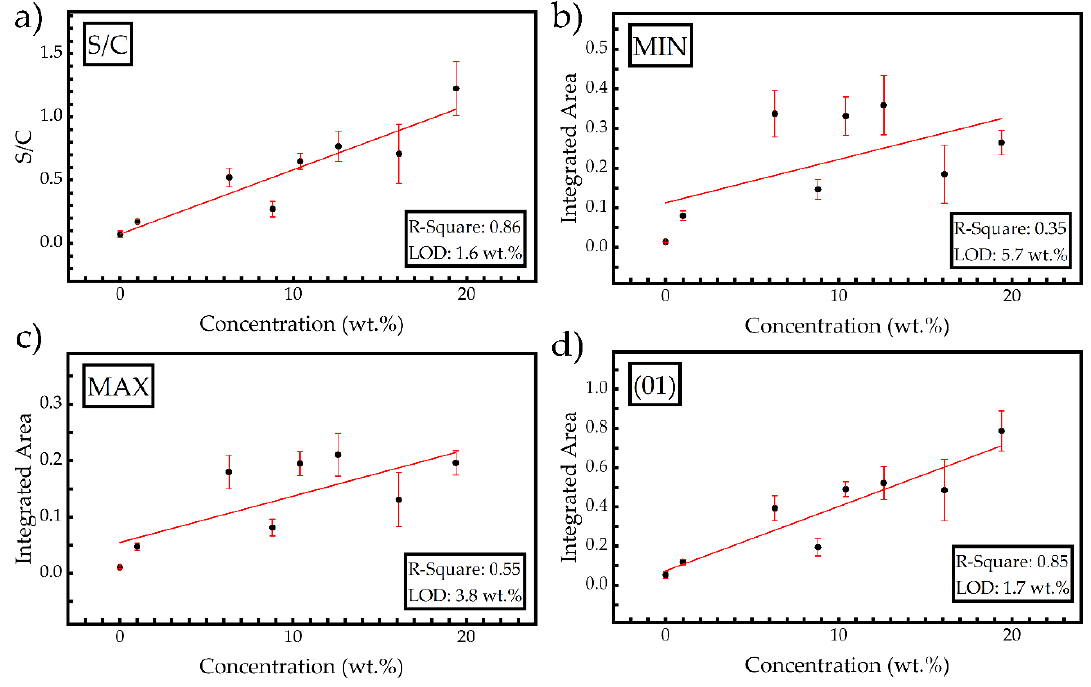
Figure 10. Calibration curves obtained using the different normalization methods, i.e., ( a ) S/C, ( b ) MIN, ( c ) MAX and ( d ) (01).